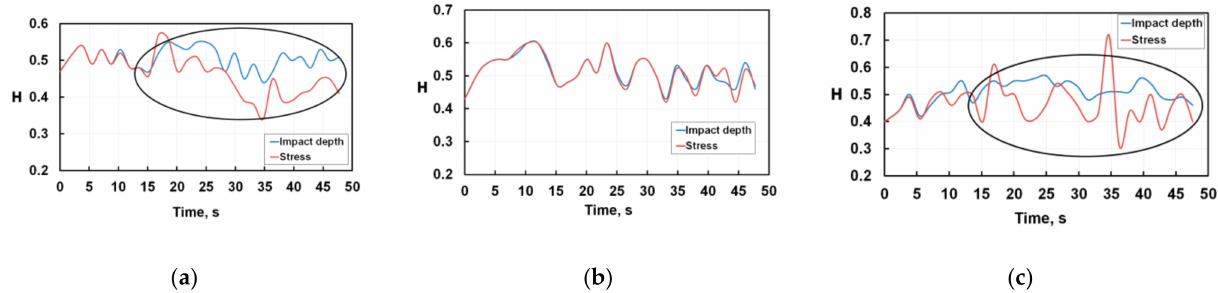
Figure 3. Cyclic variations of Hurst exponents for fatigue tests of silicon at 30 mN ( a ), 40 mN ( b ), and 50 mN ( c )